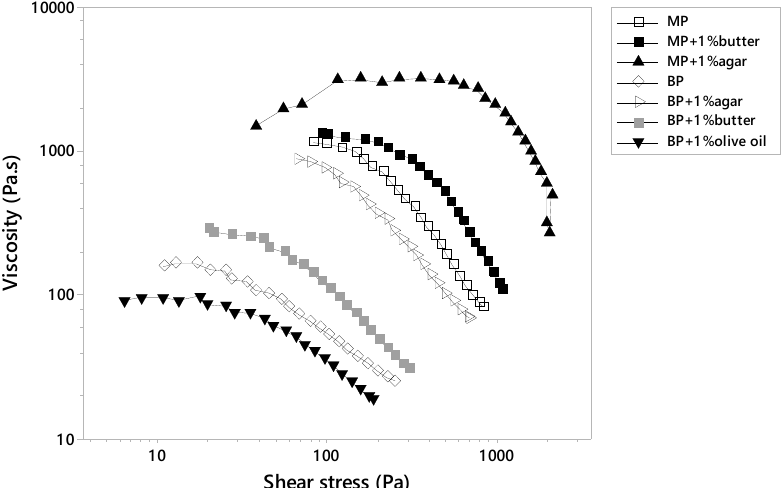
Figure 3. Measurement of the yield stress of microwaved (MP) and boiled (BP) potato with different substrates based on the stress ramp method. Table 2. Values of thixotropy and yield stress of potato tubers with di ff erent types of food additives and after being applied to two methods of cooking microwaving (MP) and boiling